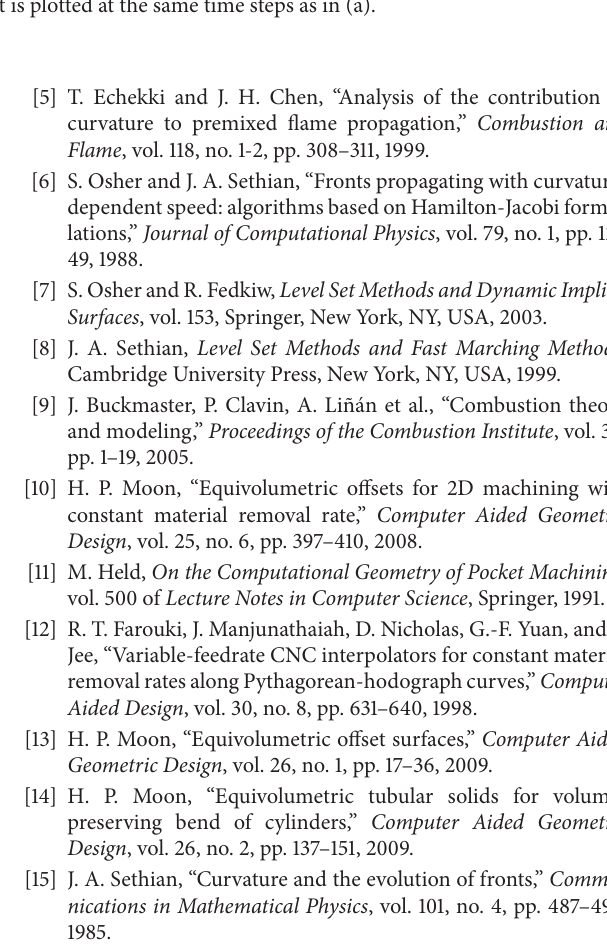
Figure 5: (a) The front evolution under the linear model starting from a seven-pointed star shaped initial front is illustrated. The evolution speed is 𝑆 0 (1 − D 𝜅) with 𝑆 0 = 0.04 and D = 0.05 . The sequence of fronts is plotted from 𝑡 = 0 to 𝑡 = 10 with Δ𝑡 = 1 . (b) The equivolumetric evolution with the volumetric ratio 𝑆 0 = 0.04 for the same initial front is plotted at the same time steps as in